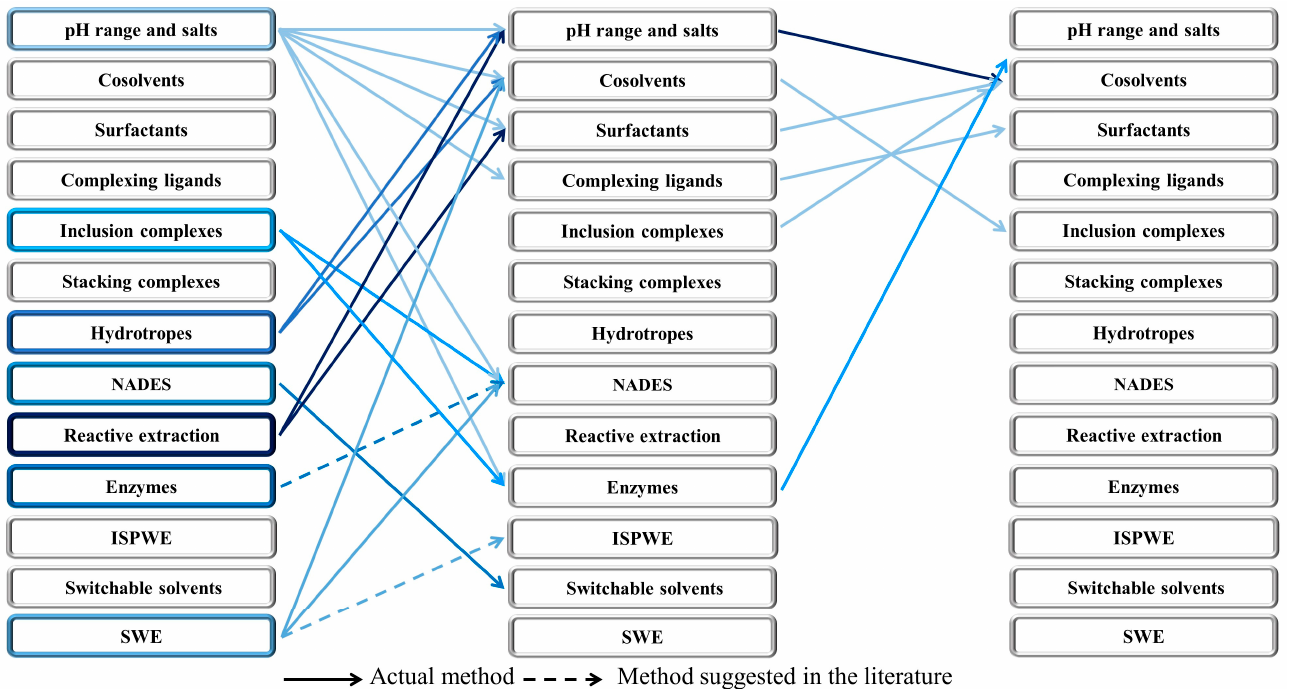
Figure 4. Future: Combinations of water extraction techniques to maximise natural compound recovery. Classic arrows indicate actual method found in the literature, while arrows with broken lines represent methods suggested by authors.